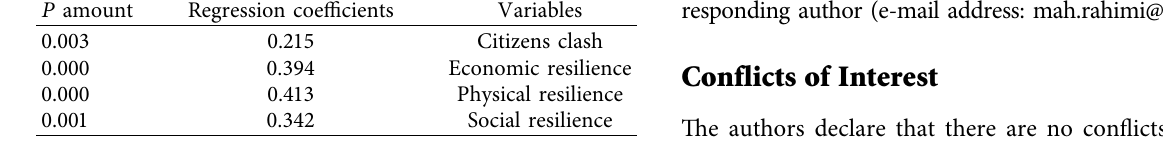
Table 7: Significance of variables in terms of regression. P amount Regression